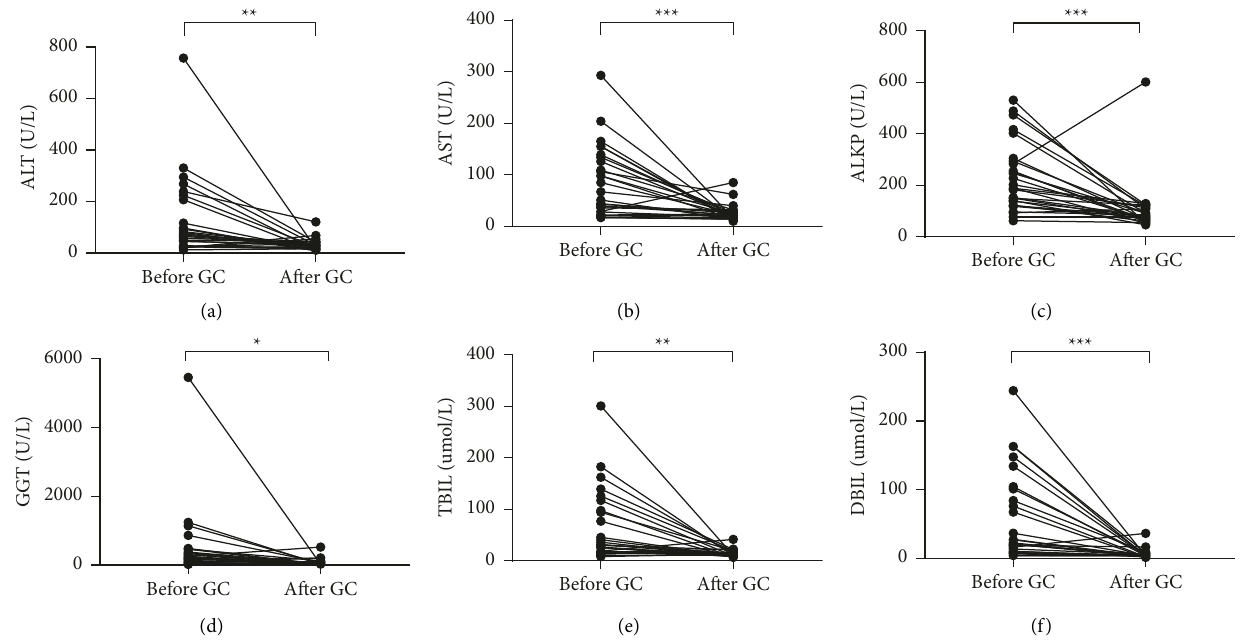
Figure 4: Liver function indices before and after glucocorticoid therapy in first-treated patients with IgG4-RD and abnormal liver